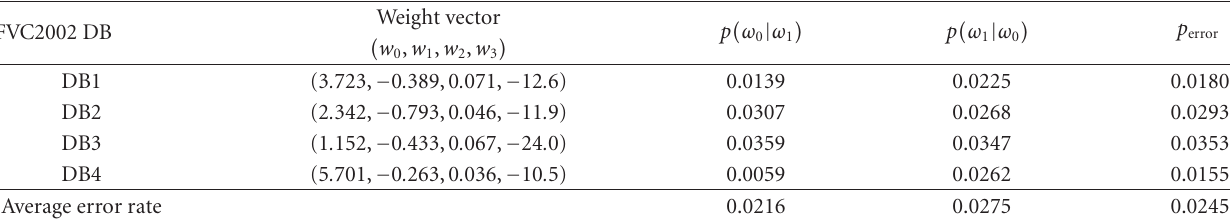
Table 5: Results of the linear classifier on FVC2002.